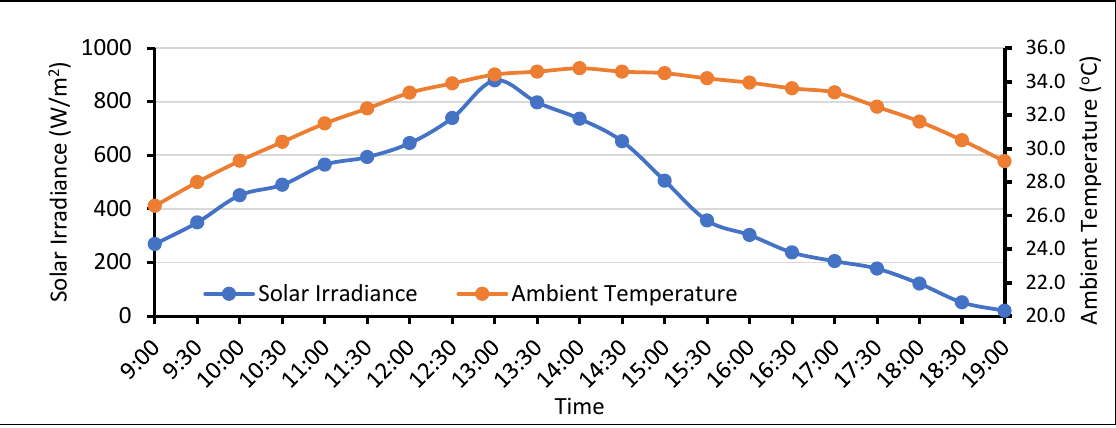
Figure 5. The mean values of measured solar irradiation and ambient temperature.